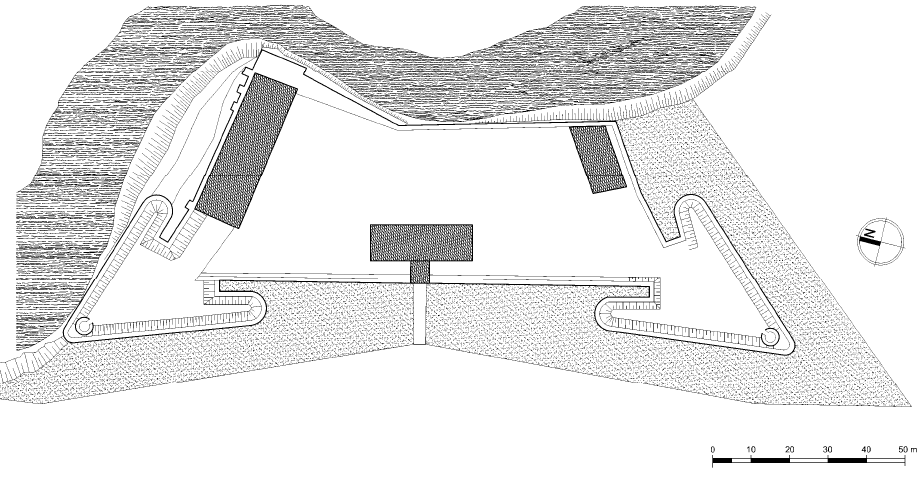
Figure 15. Ła´ncut: Lubomirscy‘s residence—palace plan with fortifications; created by authors.